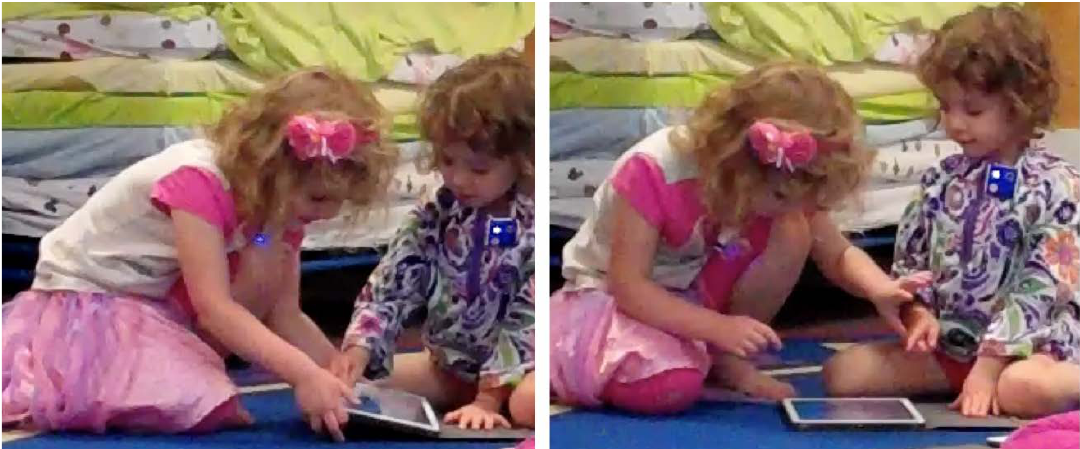
Figure 5. Participant 3 exhibiting antisocial